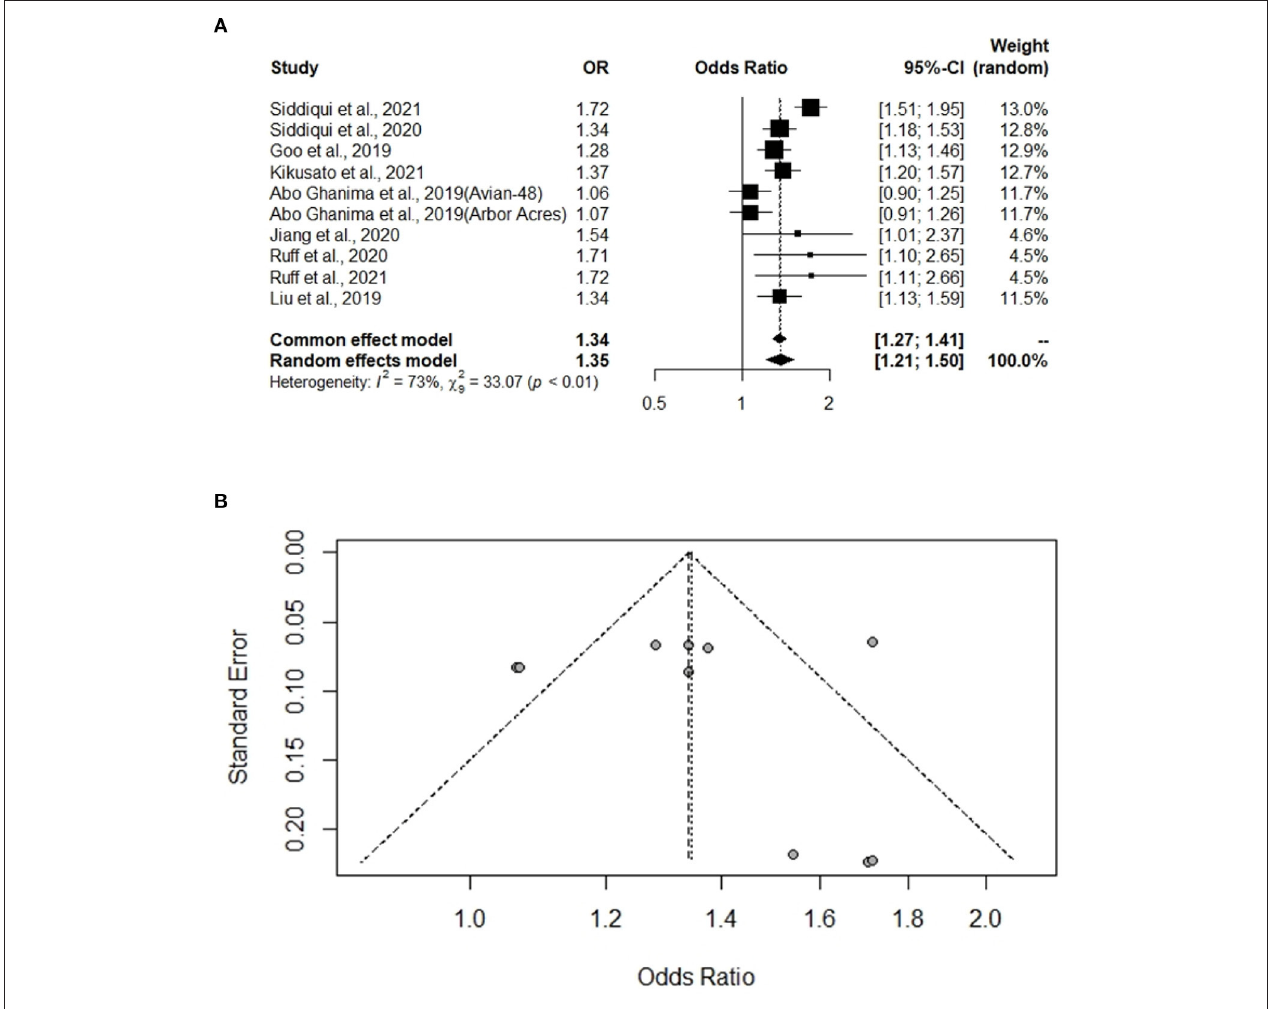
FIGURE 1 | Forest plot and funnel plot representing the effect of heat stress on broiler body mass gain. (A) Forest plot indicates that the heat stress significantly changes the body mass gain and (B) asymmetric funnel plot indicates the possible biases of our selected